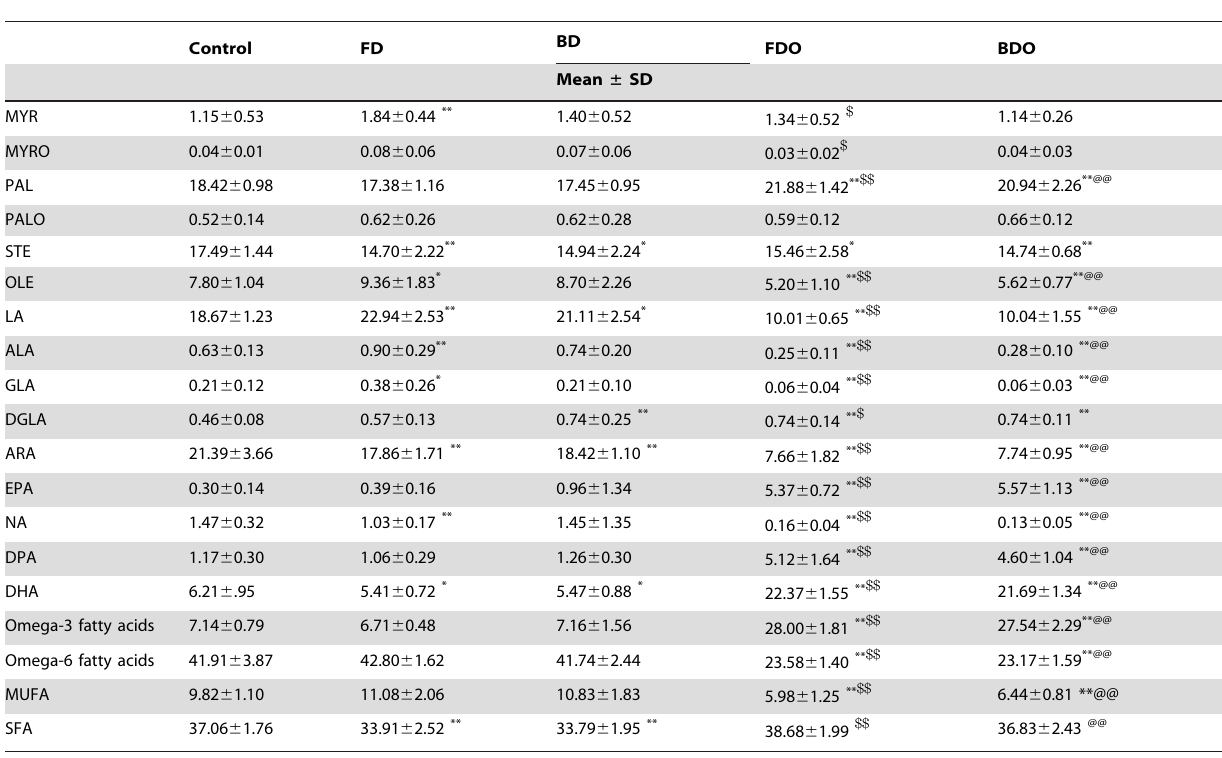
Table 4. Pup liver fatty acid levels (g/100 g total fatty acids) in different treatment